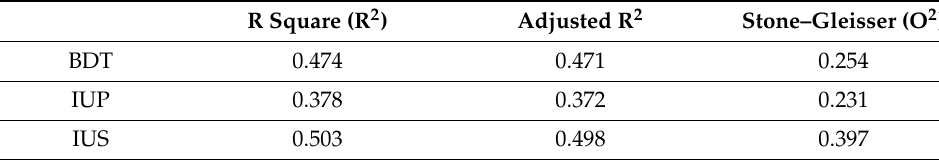
Table 4. Description of R square (R 2 ) and Adjusted R 2